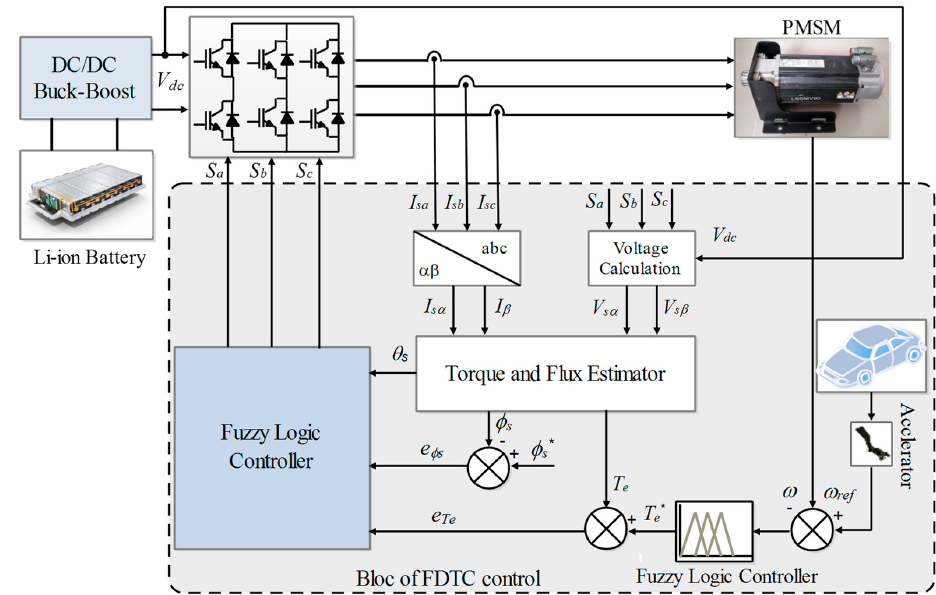
Figure 8. Bloc diagram of the FDTC technique for an PMSM in EV system.